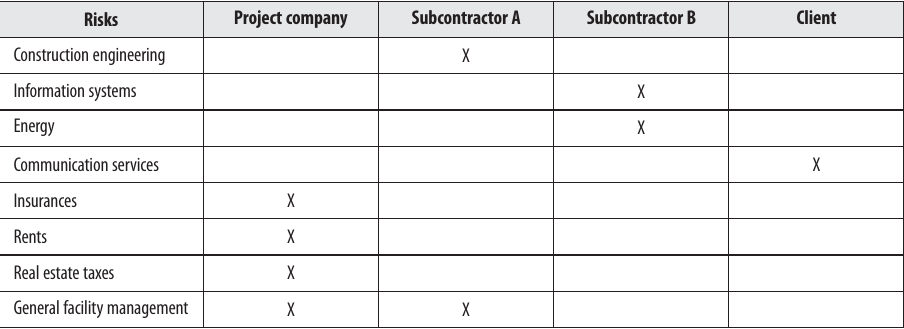
Figure 2. Parts of the risk allocation in the example